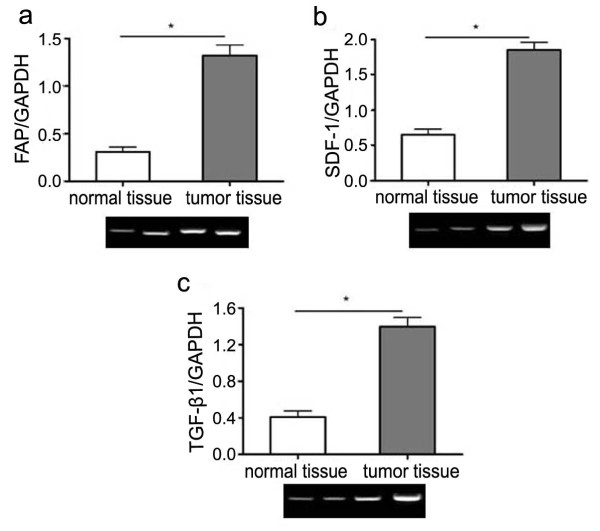
Realtime-PCR analysis of secreted proteins by CAFs in tumor and normal gastric tissues. Total RNA was extract and cDNA was prepared from surgically resected tumor and normal tissues from the same gastric cancer patients (100 cases). Realtime-PCR was carried out to compare the expression level of FAP (a), SDF-1 (b) and TGF-β1 (c) in tumor and normal tissues, the first two lanes of the electrophoretogram represented normal tissues and the last two lanes represented tumor tissues. *:p < 0.01.